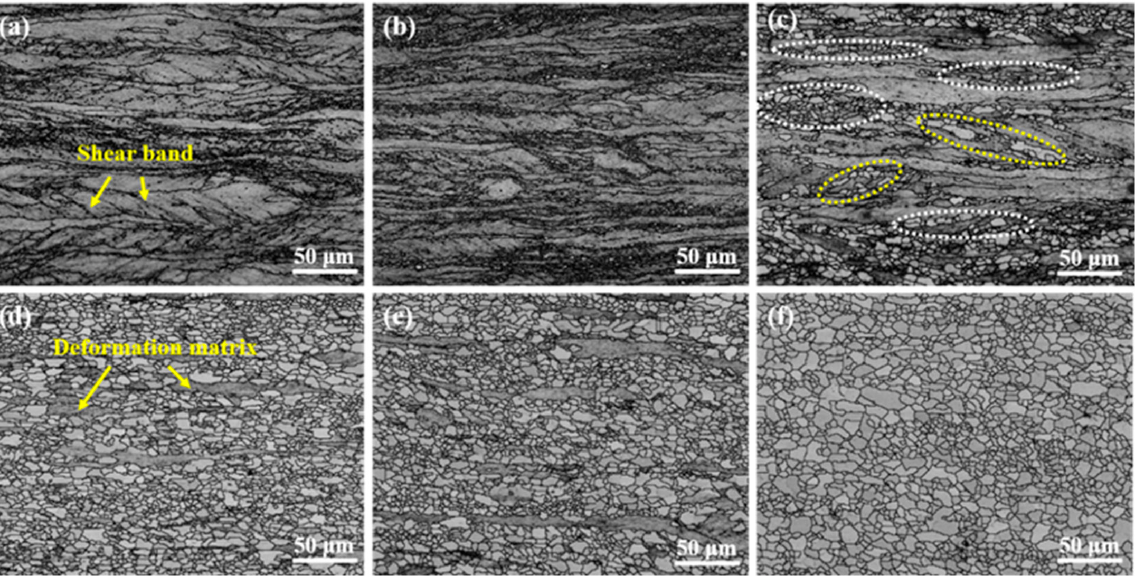
Figure 1. Microstructure of Cr-Ti-B LC steel at various continuous annealing temperatures: ( a ) initial microstructure, ( b ) 660 °C, ( c ) 680 °C, ( d ) 700 °C, ( e ) 720 °C and ( f ) 740 °C . microstructure, ( b ) 660 ◦ C, ( c ) 680 ◦ C, ( d ) 700 ◦ C, ( e ) 720 ◦ C and ( f ) 740 ◦